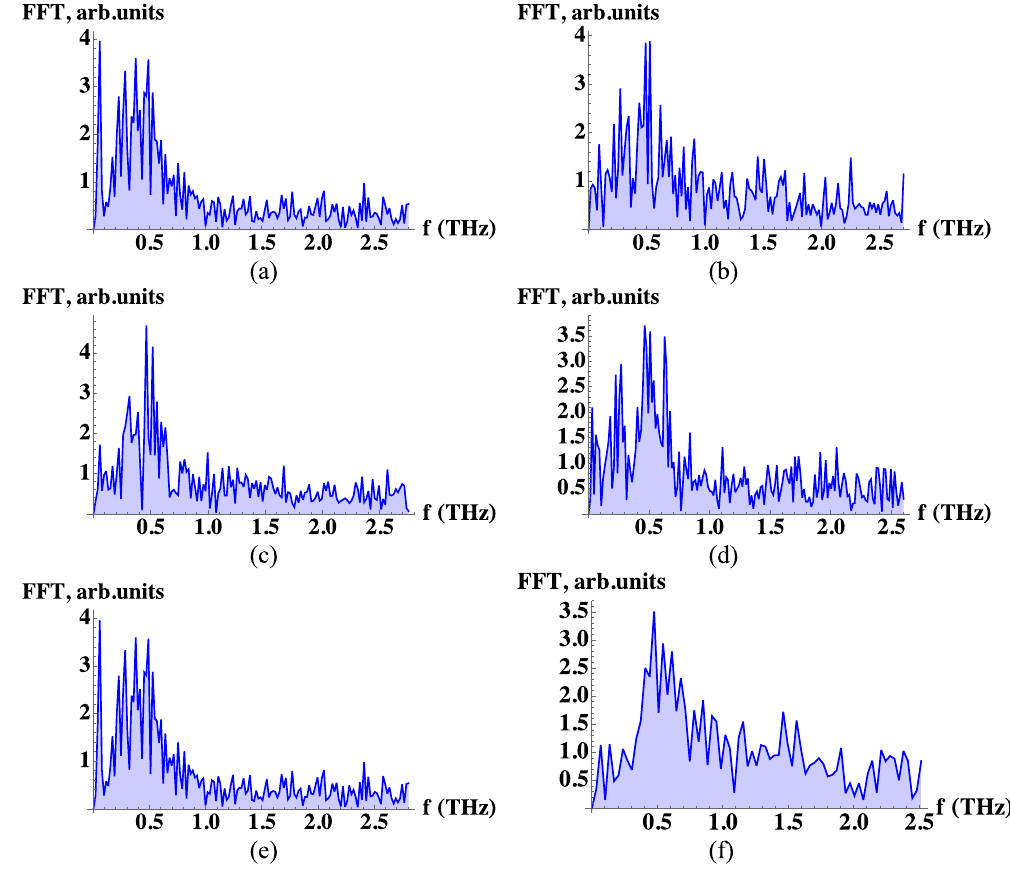
FIG. 20. Fourier spectra of measured structures in the 1.7 MeVelectron beam time: (a) – (e) — using 100-kV linac voltage and (f) using 200-kV linac voltage. The vertical scale is in arbitrary units. Since phases of the harmonics are random, we plot only the amplitudes of the Fourier